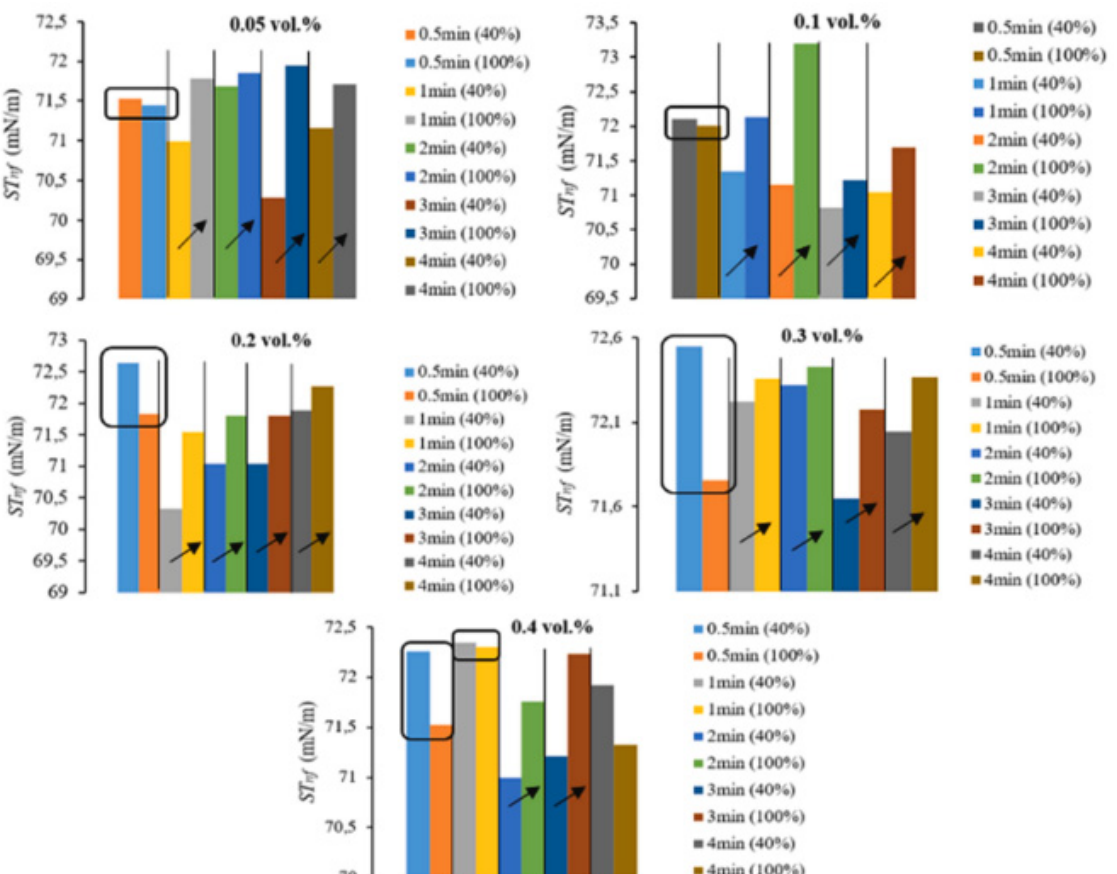
Figure 16. Effects of sonication amplitude (% in the parentheses) and time on ST nf of ZnO/DW NFs. Adapted from [176].